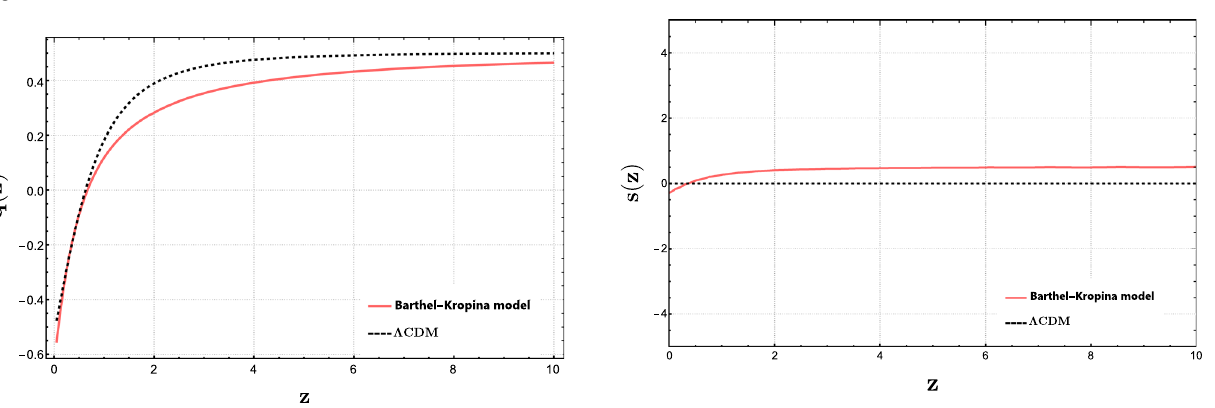
Fig. 4 The variation of the difference between the Barthel–Kropina dark energy model, and the (cid:2) CDM model as a function of the redshift z against the Hubble measurements